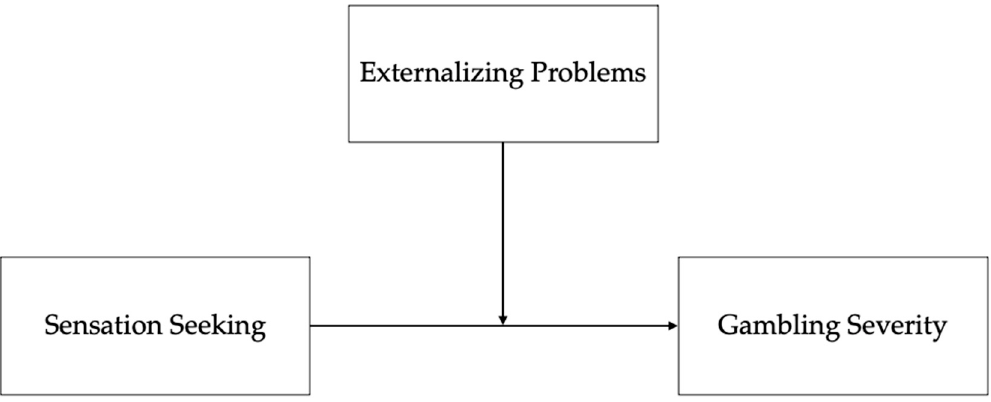
Figure 1. Conceptual model tested.